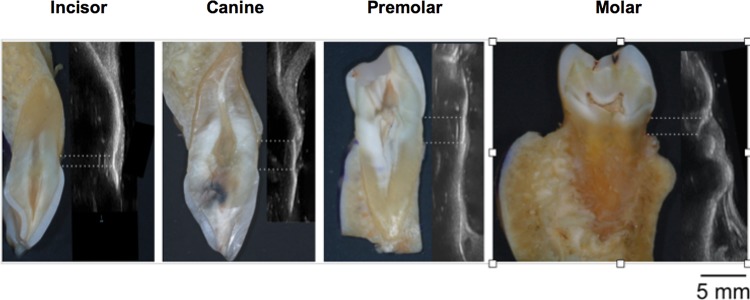
Demonstrations of ultrasound images for different tooth types in relation to the ground sections of the respective teeth.The two dashed lines represent the CEJ and alveolar bone crest level, respectively.